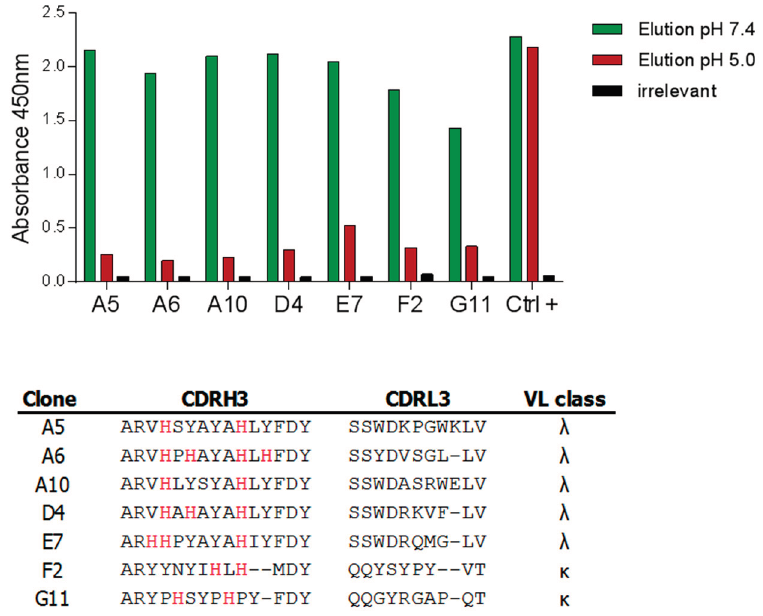
Figure 4. Isolation of pH-dependent anti-hFc antibodies. The output from round 3 was screened by pH-dependent scFv ELISA. The binding of clones to two different targets (one human IgG and one hFc-tagged protein) was assessed and clones were considered positive if binding to both targets was observed. An elution step at pH 7.4 or pH 5.0 was performed. Binding was considered to be pH-dependent if the signal obtained was at least twice that observed at pH 5.0. Clones were simultaneously tested on an irrelevant target to assess unspecific binding. The results obtained with a selection of pH-dependent hits against a human IgG1 antibody are displayed as well as the CDR3 sequences of these